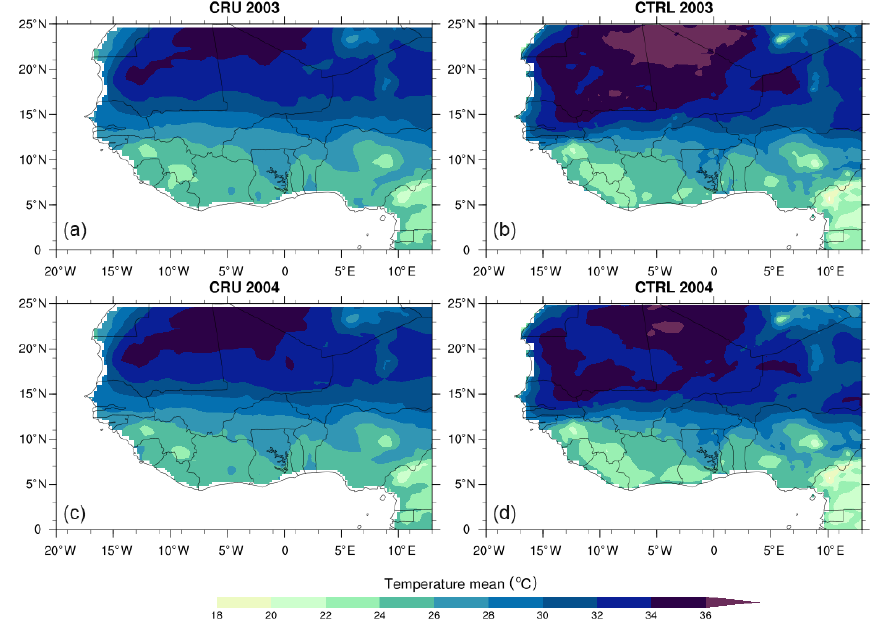
Figure 11. Mean 2m temperature ( ◦ C) from CRU (a, c) for JJAS 2003 and JJAS 2004 and the simulated control experiment (b, d) with the reanalysis initial soil moisture from